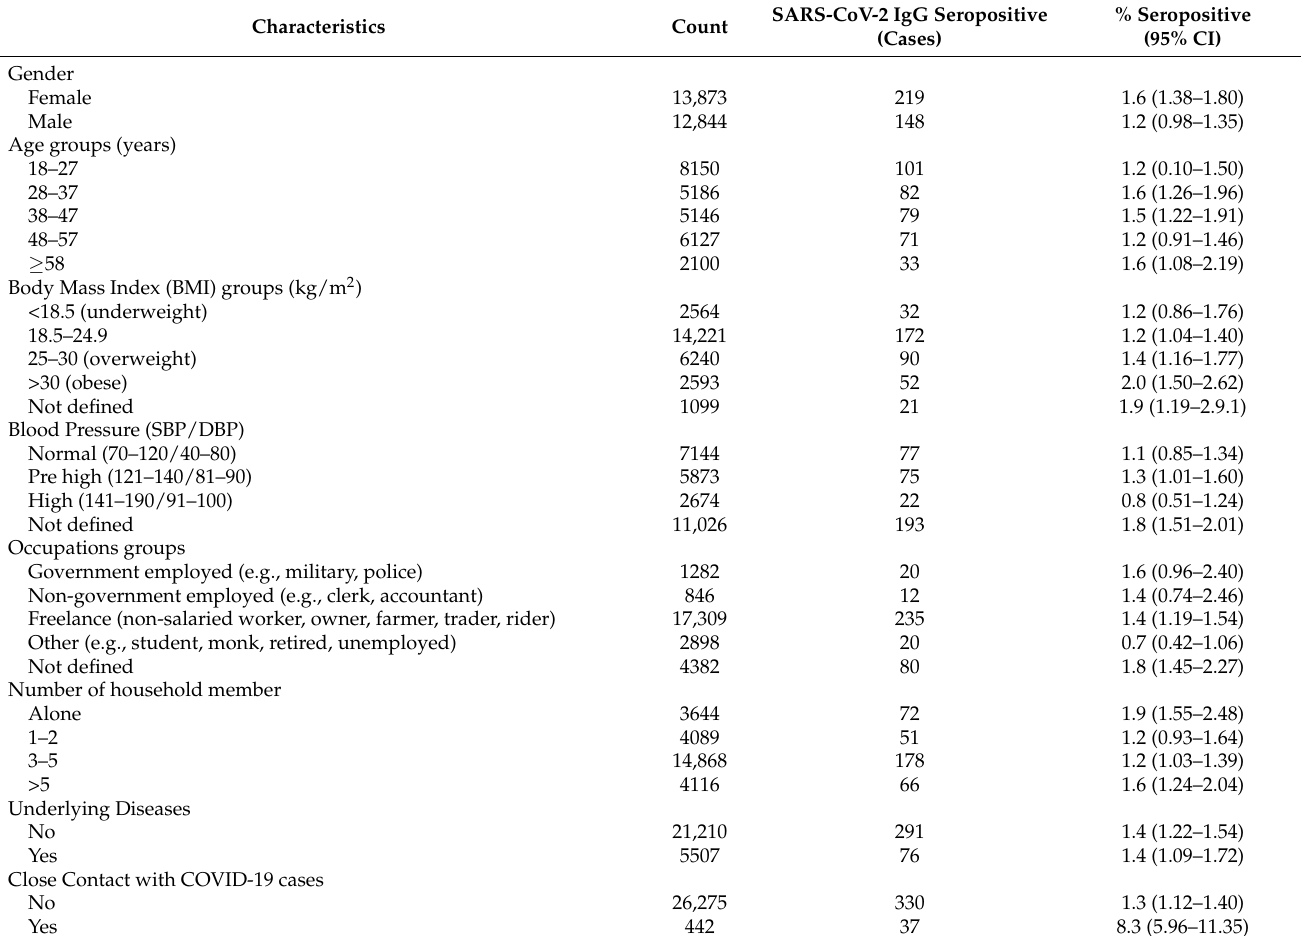
Figure 2. A flowchart of the interpreted sample results of the 1st and 2nd SARS-CoV-2 antibody tests. Table 3. SARS-CoV-2 IgG serological test